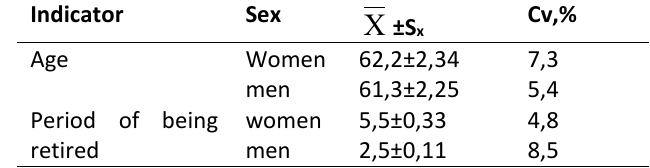
Table 1. Mean age and time of being retired depending on respondents’ sex.